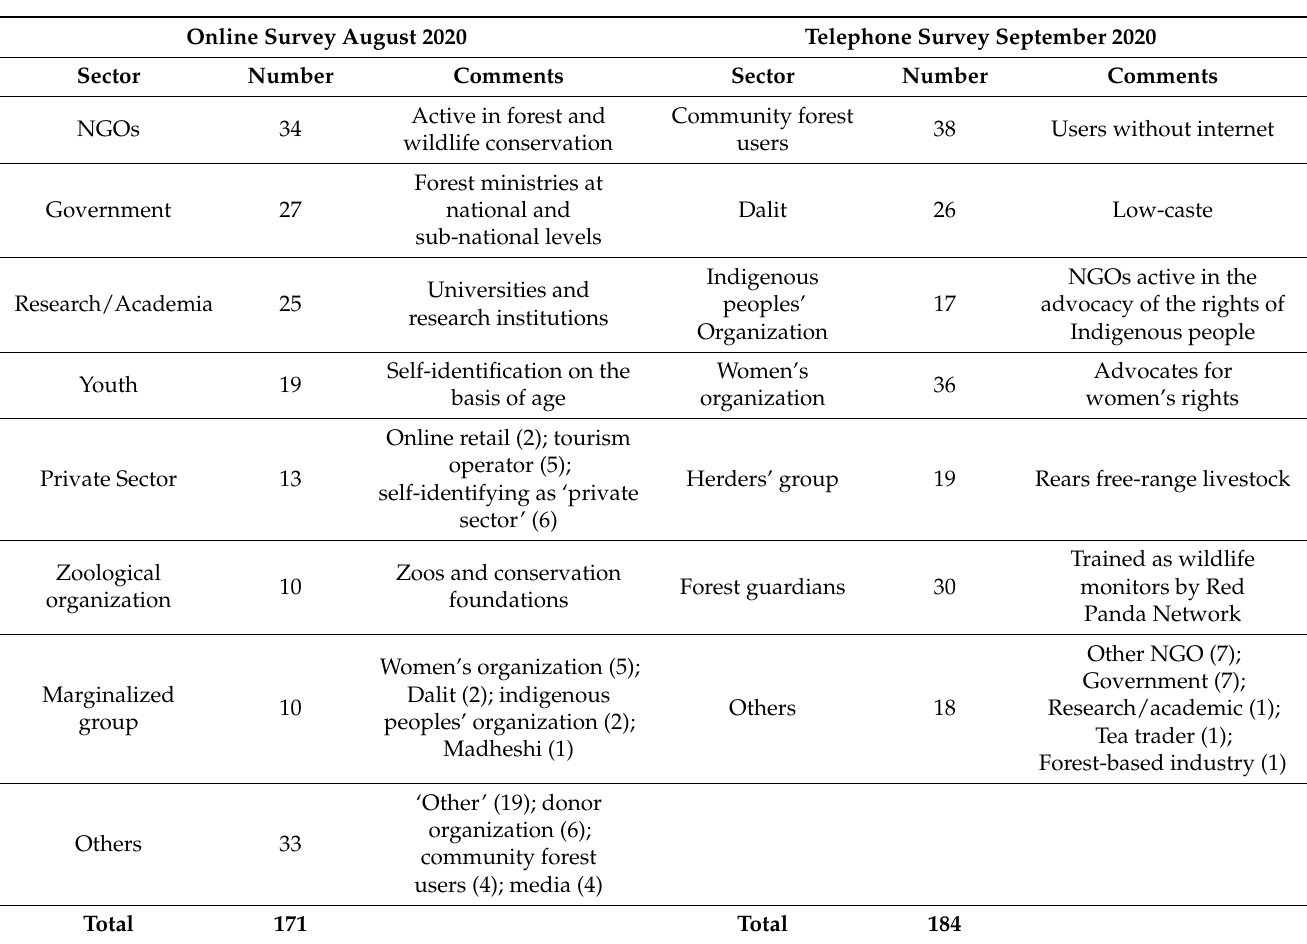
Table 2. Breakdown of respondents to two surveys on the quality of forest governance in